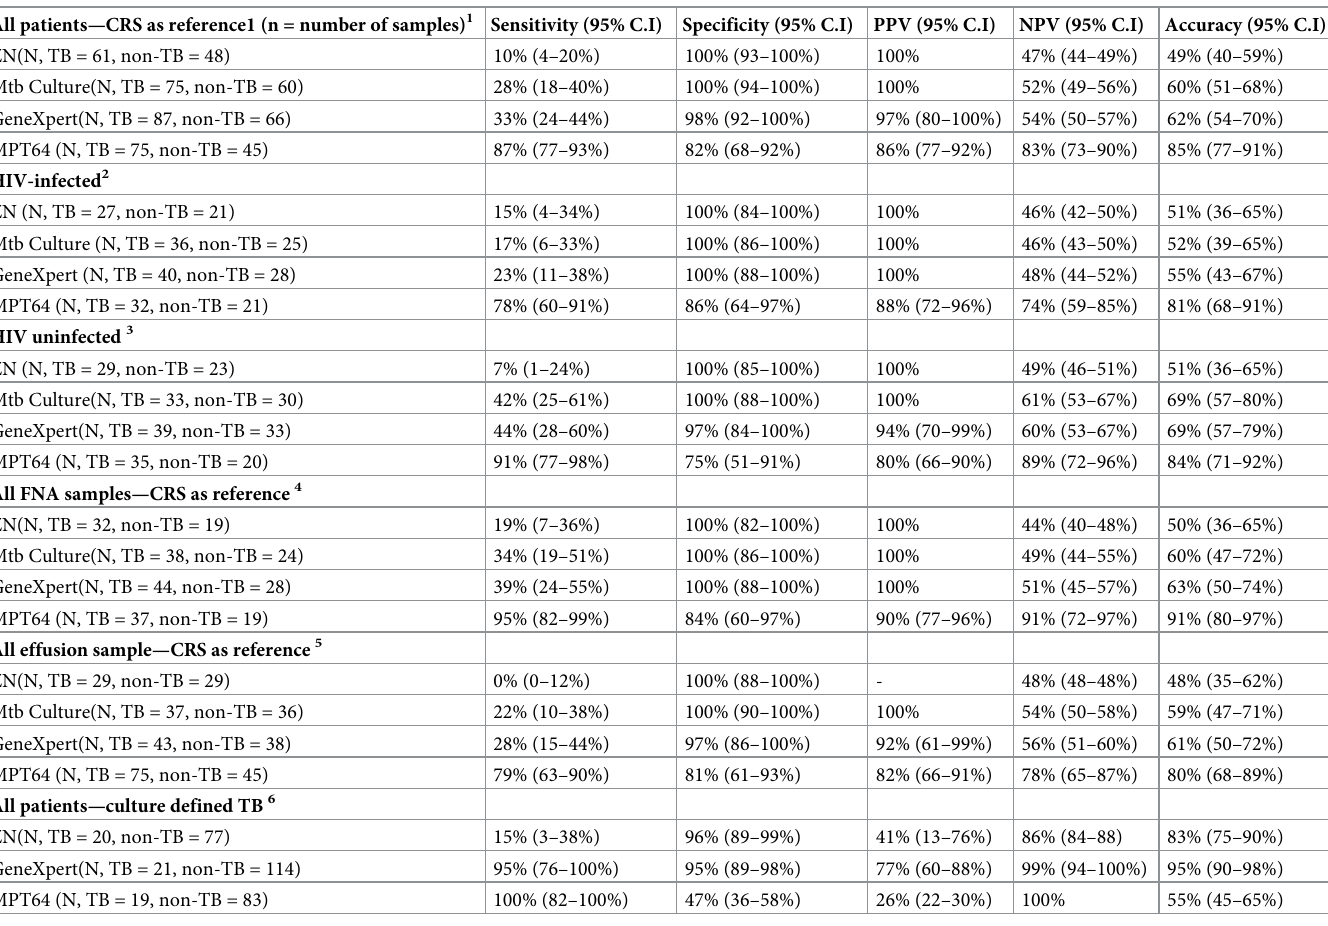
Table 3. Validation of all diagnostic tests by using composite reference standard and culture as the reference standard according to the HIV serostatus. All patients—CRS as reference1 (n = number of samples) 1 Sensitivity (95% C.I) Specificity (95% C.I) PPV (95% C.I) NPV (95% C.I) Accuracy (95%